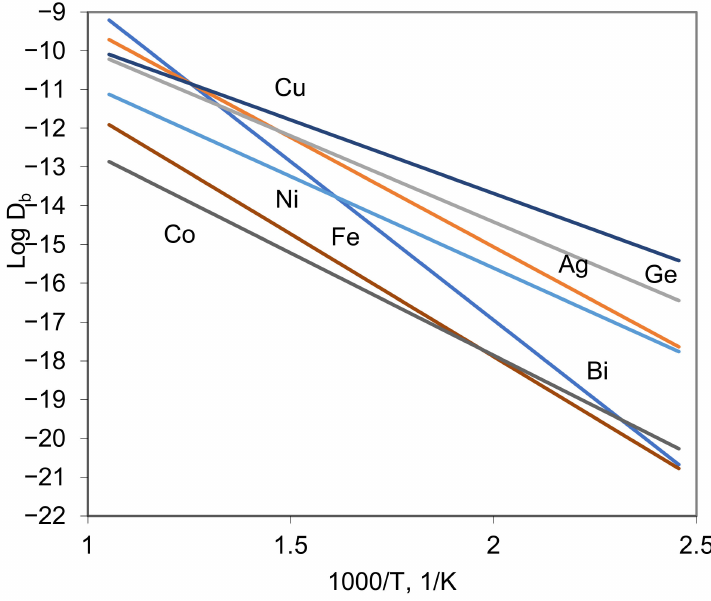
Figure 1. Compilation of recent results on Ag, Ni, Bi, Ge, Fe, Co and Cu GB diffusion in 5N8 high-purity Cu measured in “C” regime